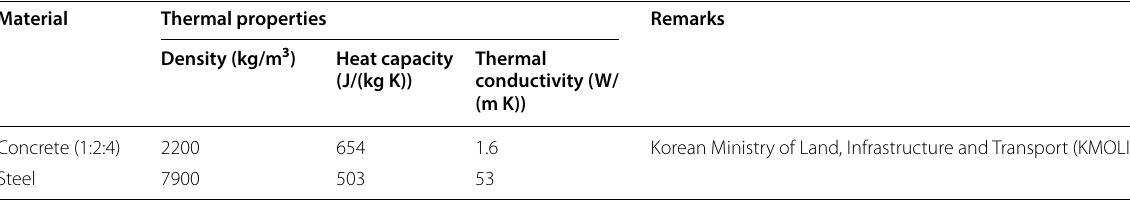
Table 1 Thermal properties of reinforced